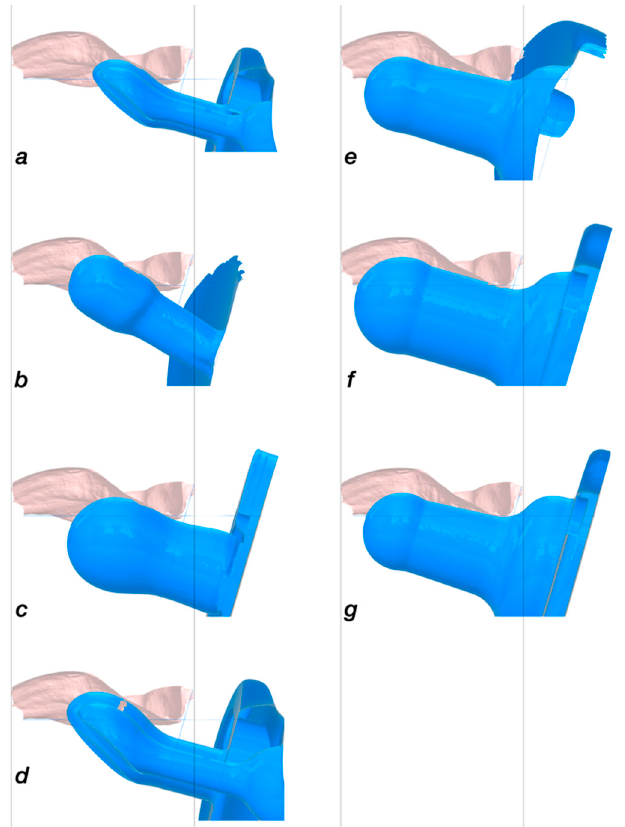
Figure 9. Preterm pacifiers placed into a palate of a female preterm infant of 35 weeks of gestational age. The length of the artificial nipples and the basic design vary considerably. For example, the shortest artificial nipple a is 4.04 mm shorter than the smallest and 7.88 mm shorter than the largest preterm measurement in this group. ( a ) = nup01; ( b ) = wt; ( c ) = bff; ( d ) = nup00; ( e ) = jpp; ( f ) = cus; ( g ) = ws.